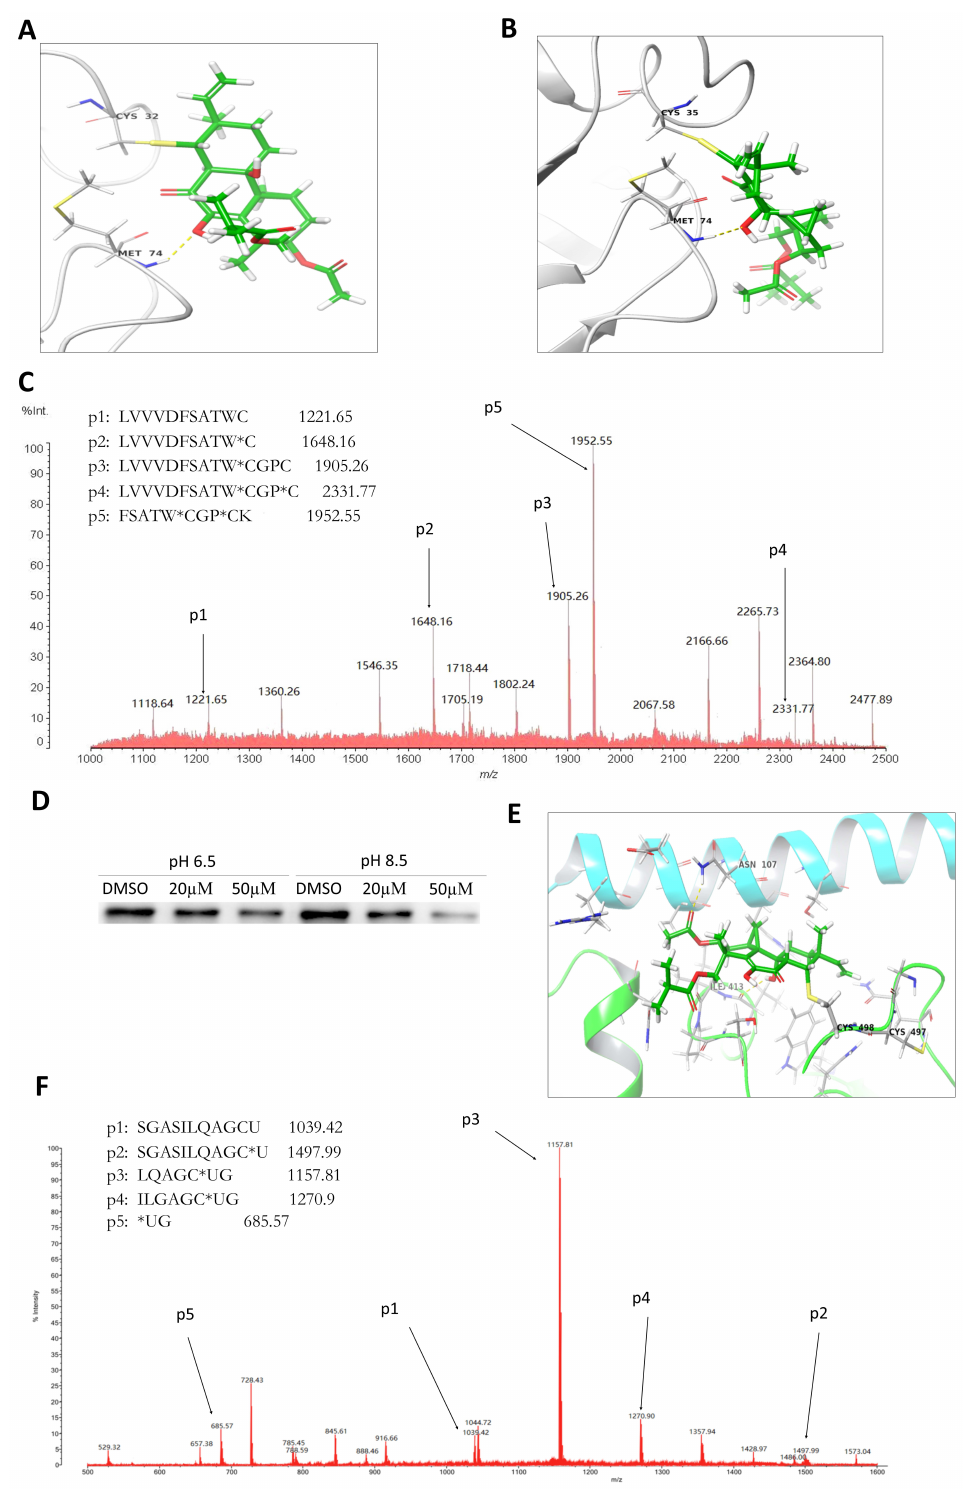
Figure 4. LH covalently binds toTrx1 and TrxR. Binding interactions between LH and Cys 32 residues ( A ) or Cys 35 residues ( B ) of Trx1 by molecular docking. ( C ), The adduct was detected by MS/MS after LH (5 mM) incubating with Trx1 (35 µ g) at 37 ◦ C for 2 h. ( D ), LH was incubated with NADPH and TrxR at 37 ◦ C for 1 h, then added to BIAM alkylation at pH 8.5 or 6.5. The same amount of dimethyl sulfoxide (DMSO) was used as a control. ( E ), Binding interactions between LH and Cys 498 residues of TrxR. ( F ), The adduct of LH and TrxR was detected by MS/MS after LH (3.3 mM) incubating with TrxR (4.8 µ g) at 37 ◦ C for 1